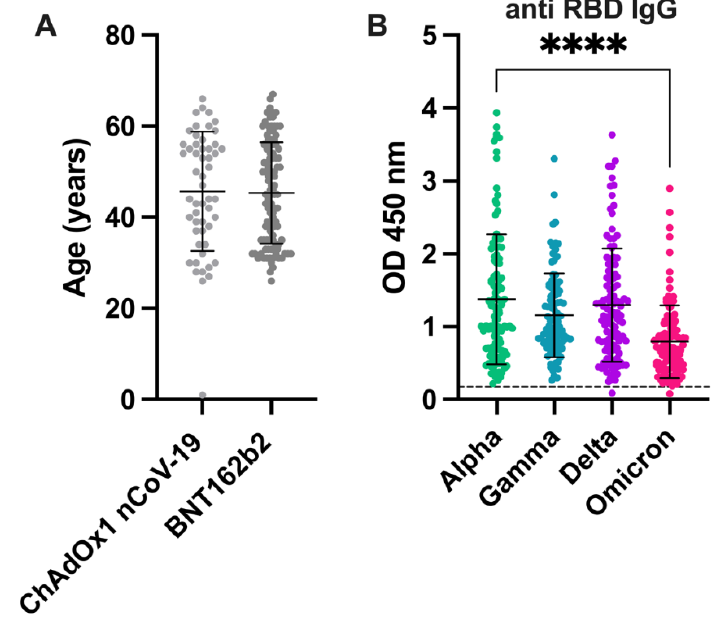
Figure 3. Age distribution of vaccinees and anti-RBD IgG levels against SARS-CoV-2 variants. ( A ) Age distribution of participants receiving ChAdOx1 nCoV-19 (Oxford/AstraZeneca) or BNT162b2 (Pfizer); ( B ) Anti-RBD-domain IgG levels detected against the variants Alpha, Gamma, Delta, and Omicron after vaccination regardless of vaccine type; **** p < 0.0001 , hyphenated line represents the test cut-off.